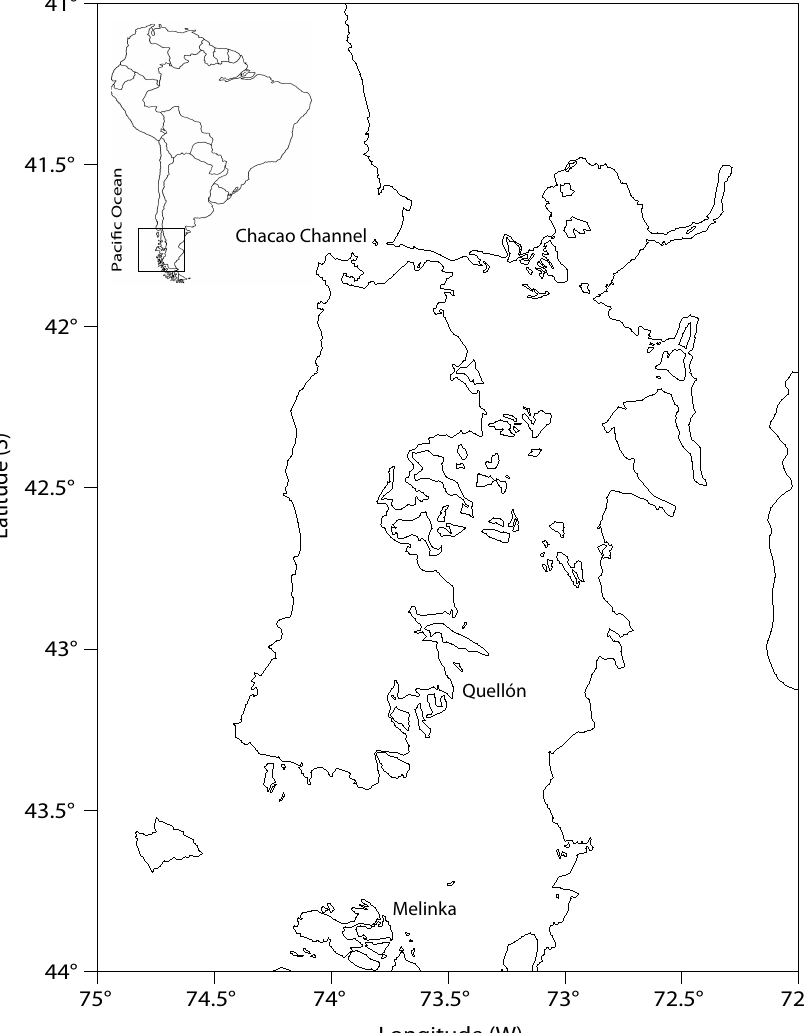
Figure 1. Study area restricted to catches of sea urchin of Chiloé Island (41 ◦ 47 (cid:48) S–43 ◦ 28 (cid:48) S). The samples were taken from Melinka Port (43 ◦ 53 (cid:48) S, 73 ◦ 44 (cid:48) W) and Quellón Port (43 ◦ 06 (cid:48) S, 73 ◦ 36 (cid:48) O). As a reference, Chacao Channel ( ∼ 41 ◦ 47 (cid:48) S) is indicated as the northern edge of Chiloé